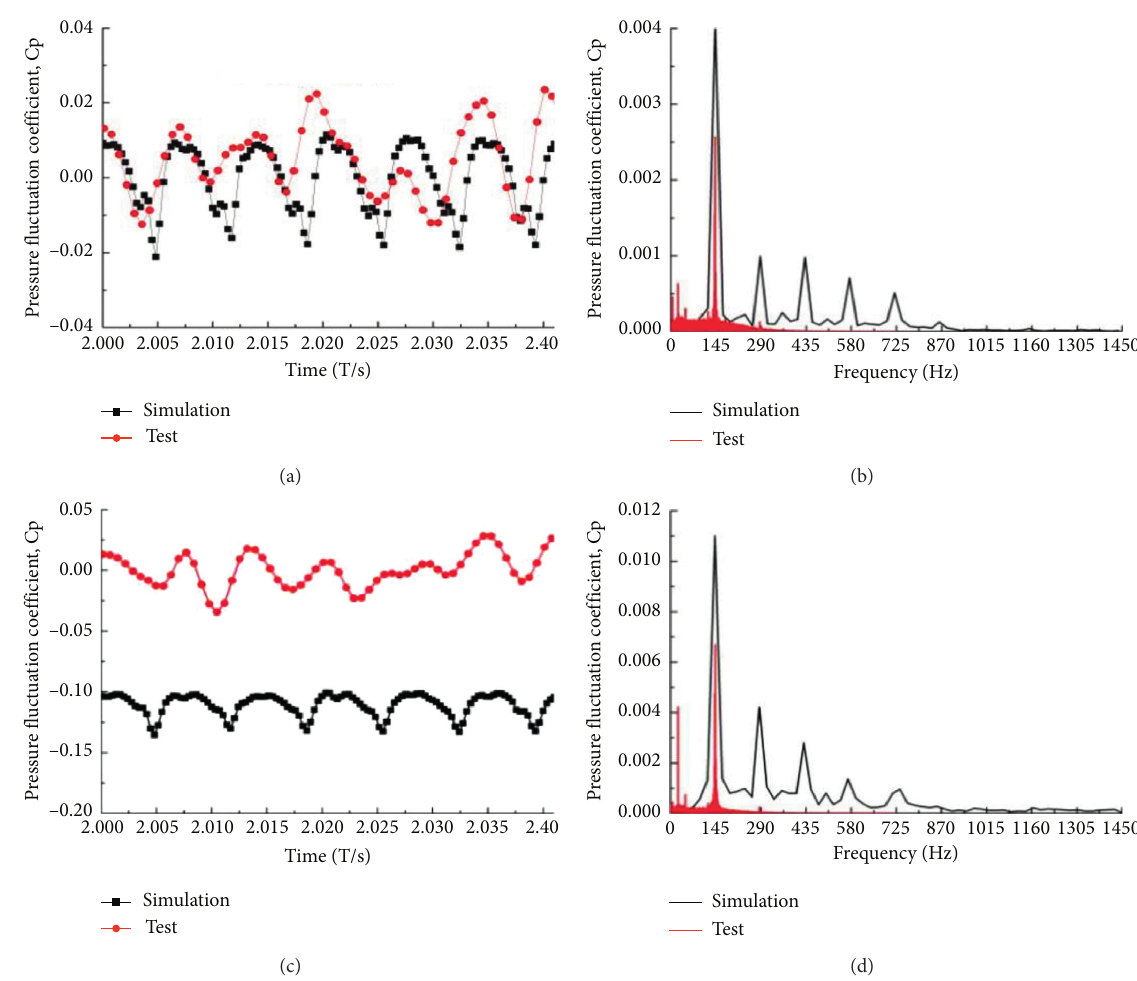
Figure 4: Comparison of numerical simulation and test of pressure pulsation at monitoring points P3 and P4 under 1.0 Q/ Q condition. (a) Monitoring point P3 pressure pulsation time domain. (b) Monitoring point P3 pressure pulsation frequency domain. (c) Monitoring point P4 pressure pulsation time domain. (d) Monitoring point P4 pressure pulsation frequency domain.